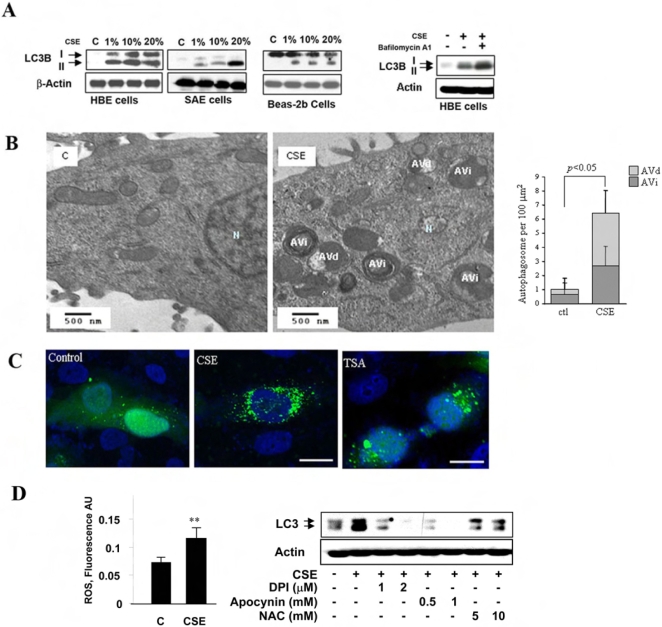
Increased Autophagy by CSE in Pulmonary Epithelial Cells.(A) Western blot analysis of LC3 in CSE-treated HBE, SAE, and Beas-2B cells. Cells were treated with various concentrations of CSE for 24 h. Far right panel shows that bafilomycin A1 enhanced the CSE-induced LC3 expression in HBE cells. Cells were pretreated with 200 nM Bafilomycin A1 for 30 min and followed by the exposure to 30% CSE for an additional 24 h. (B) Formation of autophagic vacuoles in HBE cells treated with 1% CSE for 4 h. N indicates nuclei. AVi, immature autophagic vacuoles (autophagosomes), AVd, degradative, late autophagic vacuoles (autolysosomes). (Right) EM images corresponding to HBE cell exposed to 10% CSE for 24 h scored for number of immature autophagic vacuole (AVi) and degradative autophagic vacuoles (AVd). The data are represented as AVi and AVd per 100 µm2. Data are mean scores plus standard deviation. N = 15 images representative of CSE treated cells, and N = 10 images representative of control cells, at same magnification. *P<0.05 (C) Representative images of the punctuated GFP-LC3 in Beas-2B cells treated with 5% CSE or 50 nM TSA for 24 h. White bar indicates 10 µm. (D) Increased ROS accumulation in CSE-treated Beas-2B cells. Cells were exposed to 20% CSE for 1 h. (Right) CSE-induced LC3 expression was attenuated by diphenyliodonium (DPI), Apocynin or N-acetyl-L-cysteine (NAC). Beas-2B cells were pretreated with the antioxidant at the indicated concentrations for 30 min and followed by the exposure to 30% CSE for an additional 24 h. Data represent mean+/−S.D. of three independent experiments. ** indicates P<0.01.